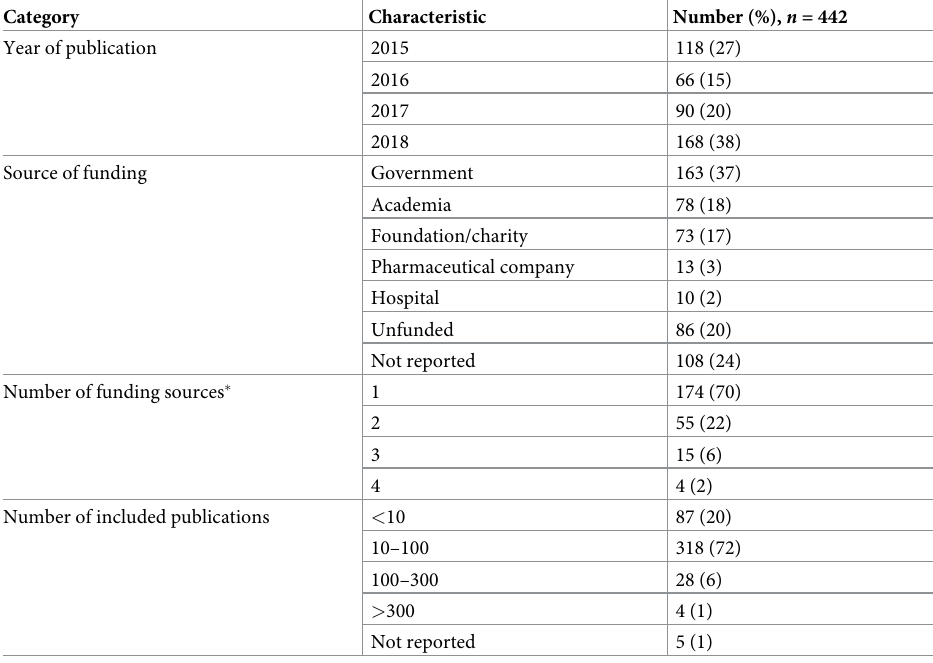
� Percent calculation out of the number of funded reviews that reported the source ( n =